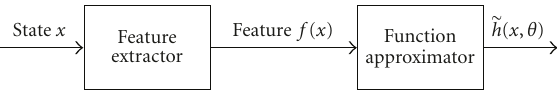
Figure 3: Architecture of RL